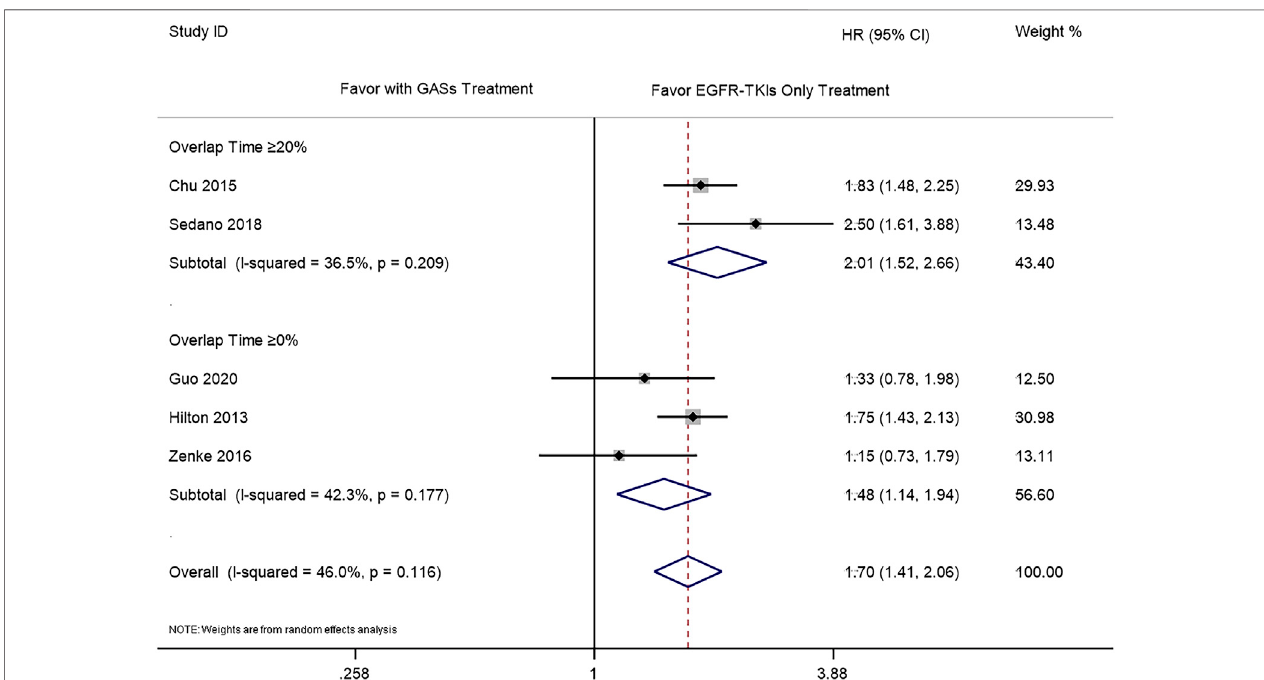
FIGURE 5 | In fl uence of concomitant use of GASs in different overlap time on the PFS.